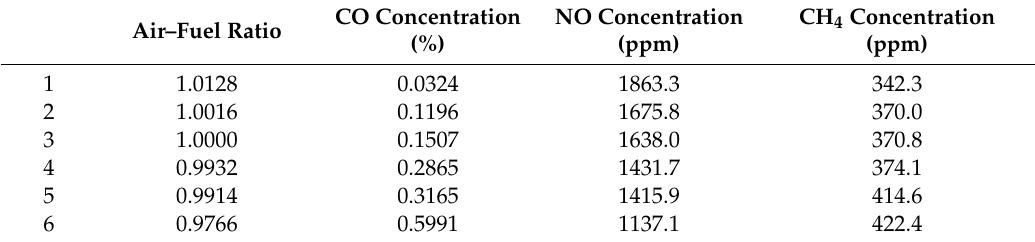
Table 5. Gas sample composition at the catalyst inlet.